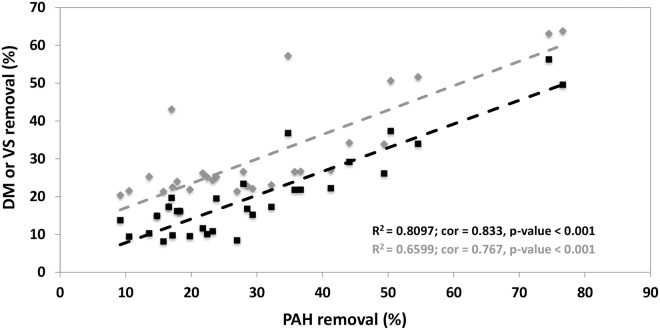
Correlation between DM (black square) or VS (grey triangle) removals and PAH removal.